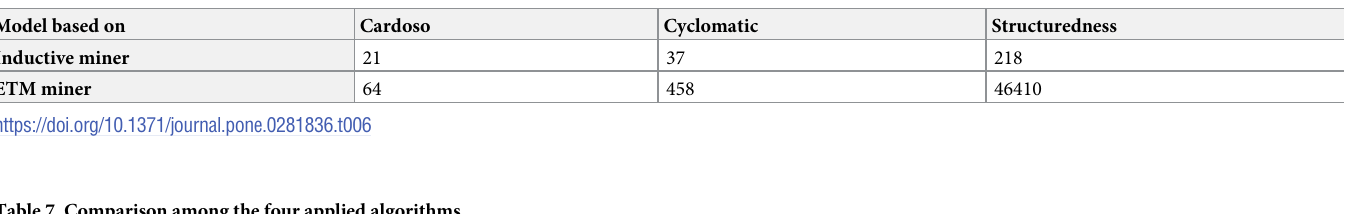
Table 6. Quantify the complexity of the model from the inductive and ETM discovery miners.